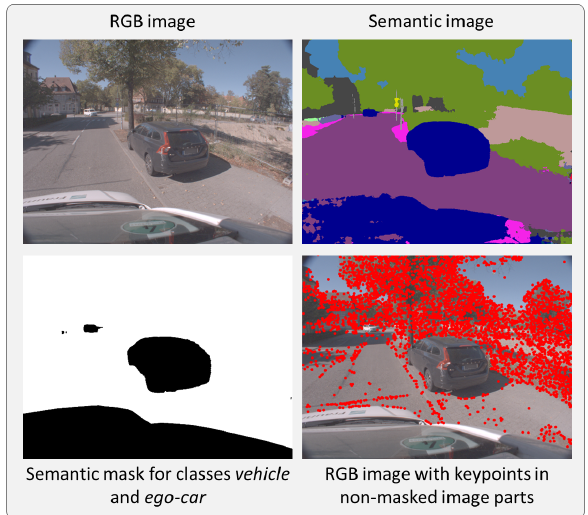
Figure 1. Top left: RGB road scene image as acquired by a vehicle camera. Top right: Semantic image obtained by semantic segmentation of the RGB image. Bottom left: Semantic mask obtained from semantic segments of the class vehicle and from the fix-pixel segment of the ego-car . Bottom right: SIFT feature keypoints detected in the RGB image considering only the non-masked image